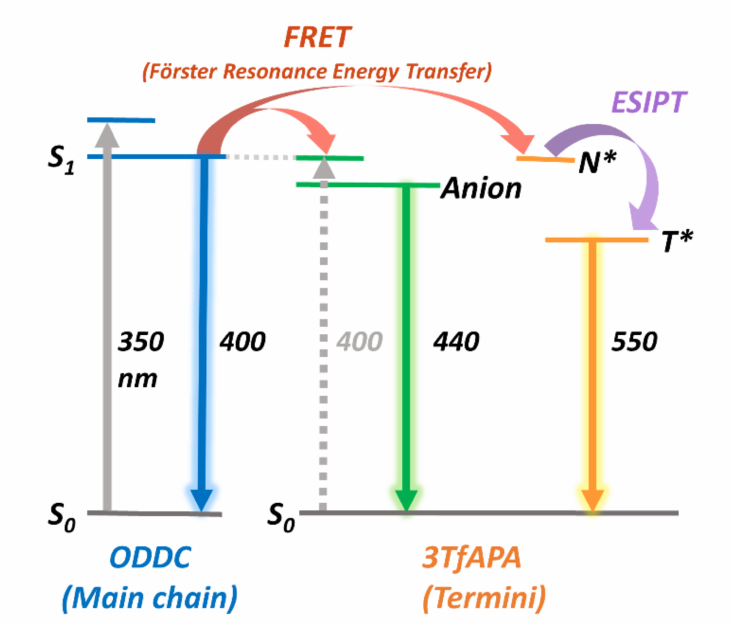
Figure 6. Photophysical processes for the end-capped PIs in the film state, illustrated by a schematic energy-state